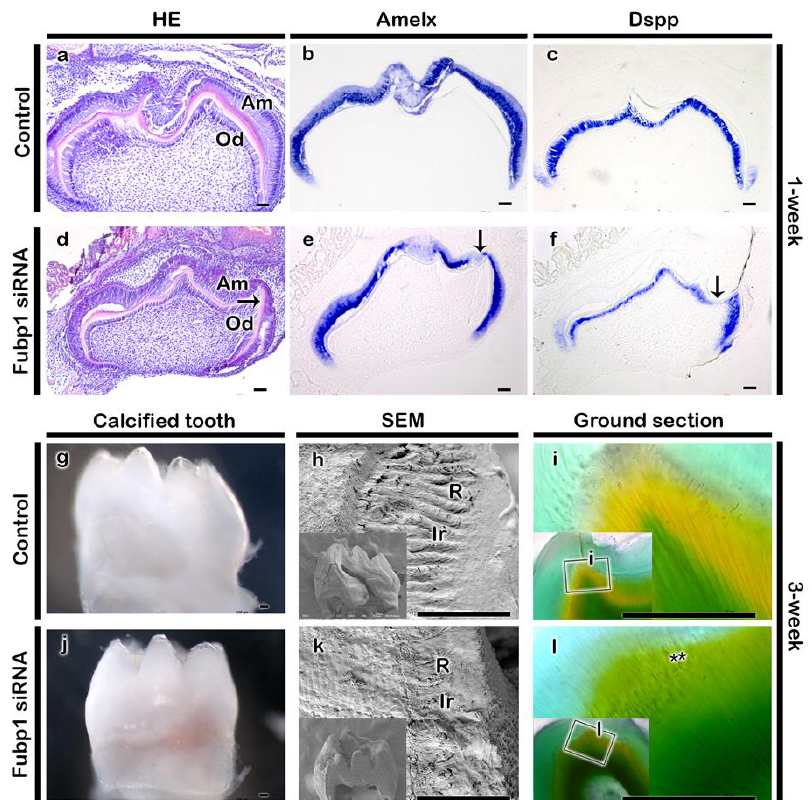
Figure 5. Renal capsule transplanted teeth for one-week and three-week. One-week ( a – f ) and three-week ( g – l ) renal calcified tooth. H&E staining showing ameloblast and odontoblast layer with enamel and dentin matrix in one-week calcified tooth. ( a , d ). Amelx and Dspp expression is relatively weaker in the Fubp1 knock-down tooth compared with the control ( b , c , e , f ). Dspp and Amelx mRNA expression is comparatively weaker in knock-down tooth especially along cusp region (arrows, ( e – f )). Three-week renal calcified control and Fubp1 knock-down tooth ( g , j ). SEM showing patterned enamel rod and interrod in the control specimen ( h ) which is abrogated in the knock-down tooth ( k ). Resin section shows well organized dentinal tubules in the control specimen ( i ), while dentinal tubules are not well arranged (indicated by double astericks) especially along the cusp of thee Fubp1 knock-down tooth ( l ). Square box indicates the magnified view ( i – l ). SEM, scanning electron micrograph; HE, hematoxylin and eosin staining; R, rod; Ir, interrod; Amelx, amelogenin; Dspp, dentin sialophosphoprotein; De, dentin; Am, Ameloblast; Od, odontoblast. Arrow in ‘d’ indicates comparatively thinner dentin layer in the Fubp1 knock-down tooth. Scale bars: 50 μm ( a – l ).